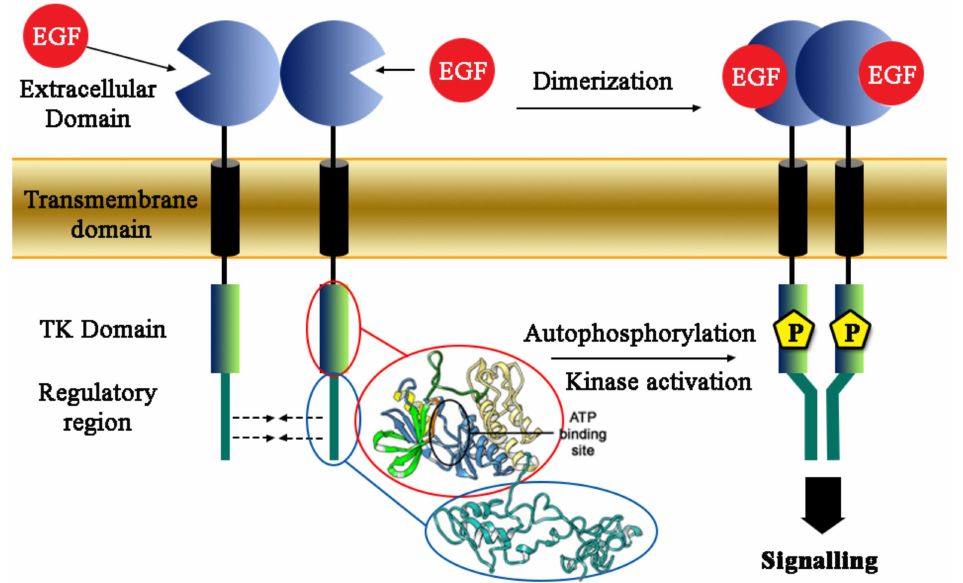
Figure 1. Epidermal growth factor receptor (EGFR) structure in cellular membrane and the dimerization